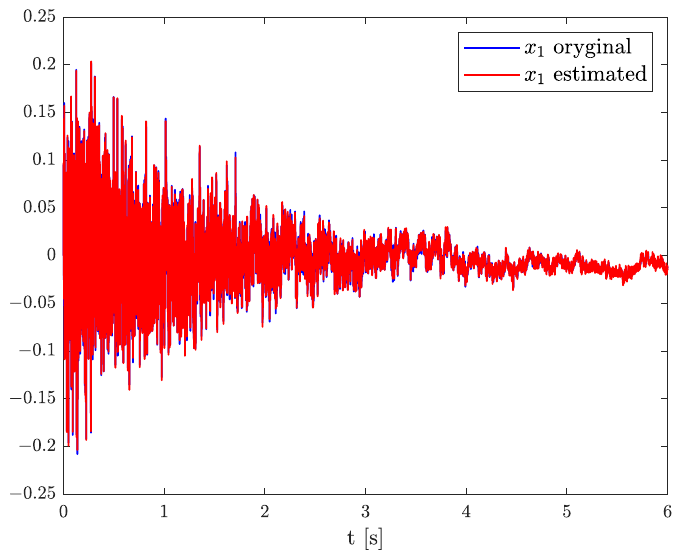
Figure 5. Original and estimated state variable from Example